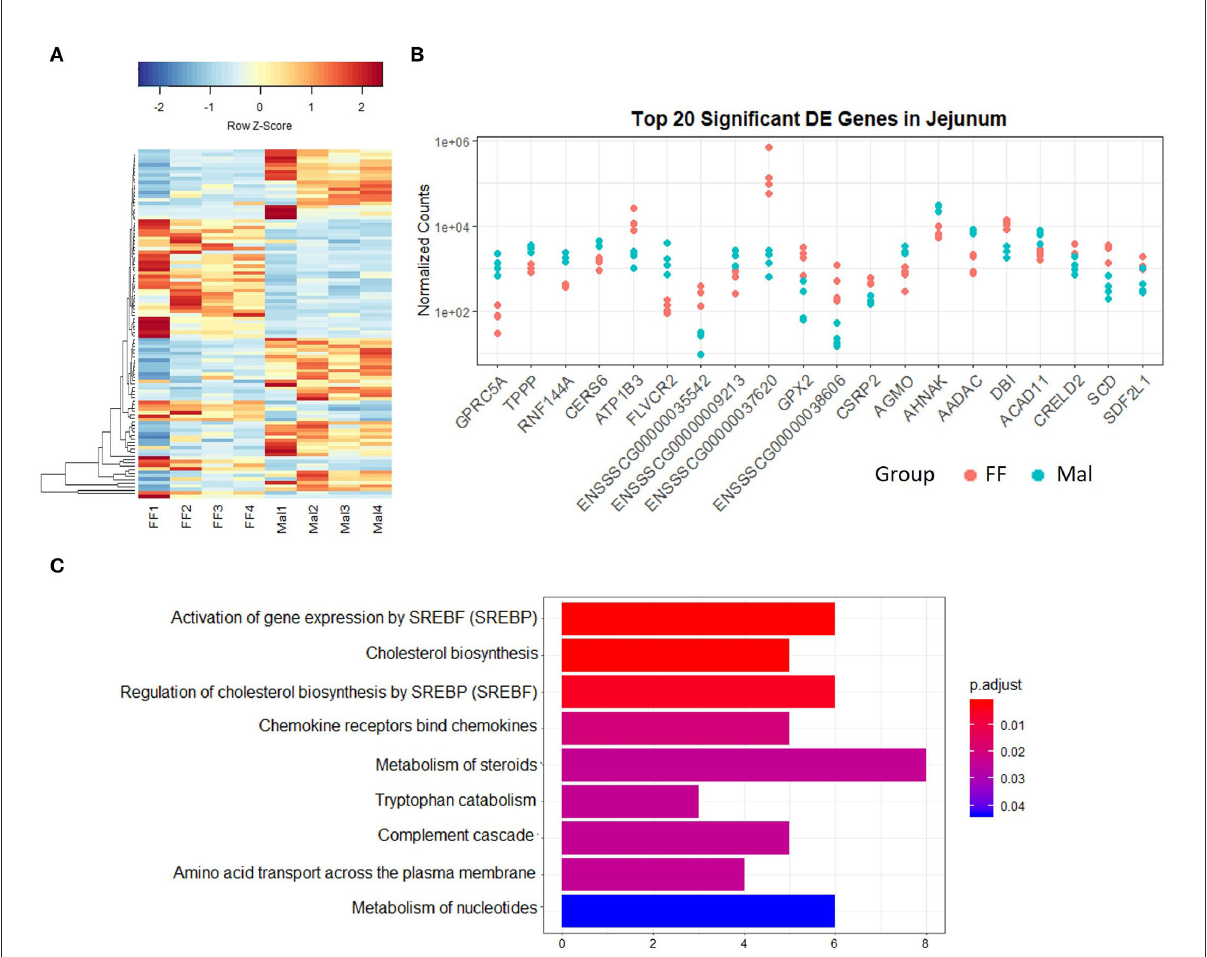
FIGURE3 Gene expression and pathway analysis in the jejunum of full-fed and malnourished pigs. (A) Heatmap with hierarchical supervised clustering of the normalized counts using Euclidean distance for the 100 DE genes with the greatest variance between the full-fed (FF, n = 4) and malnourished (Mal, n = 4) groups in the jejunum. Z-score represents upregulated (red) and downregulated (blue) genes, with a color gradient indicating expression level. (B) Plot of the normalized counts of the 20 genes with the lowest padj values in the jejunum of FF [ n = 4 (pink)] and Mal [ n = 4 (blue)] animals. The genes are ordered left to right from lowest to greatest padj values. (C) Reactome analysis of downregulated genes in the jejunum of FF compared to Mal piglets in the jejunum. Bar length represents the counts of genes DE in each pathway, and colors represent the padj value.